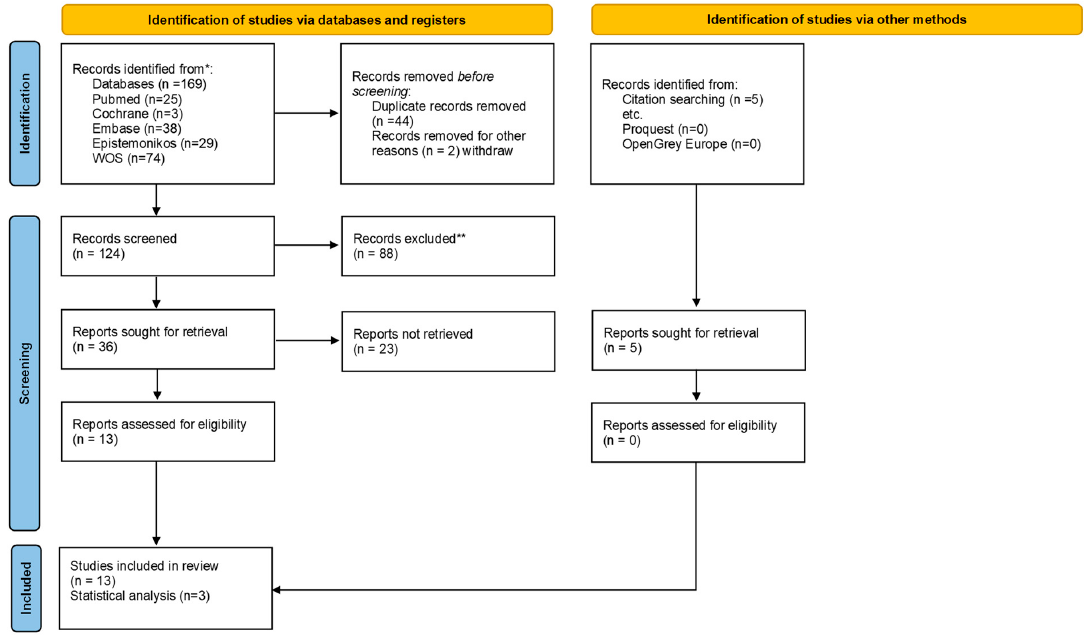
Figure 1. Flowchart of umbrella review.